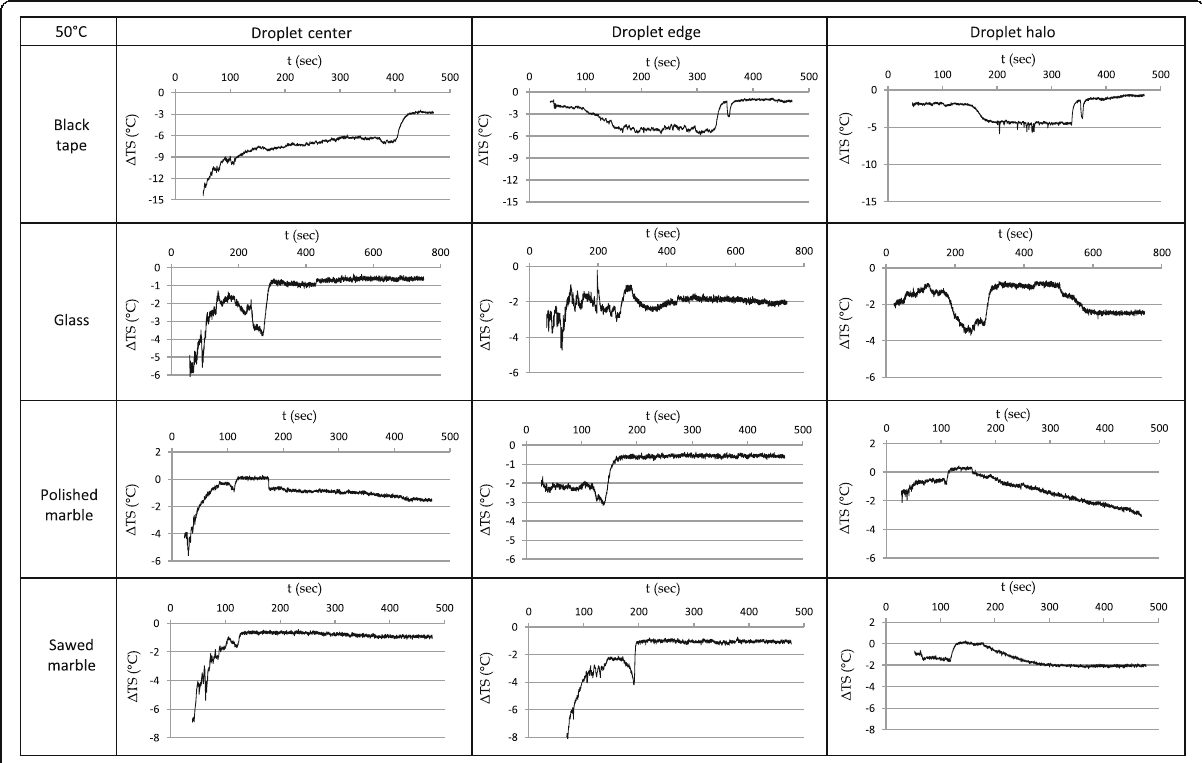
Fig. 6 IRT profiles of each droplet zone at 50 °C for each